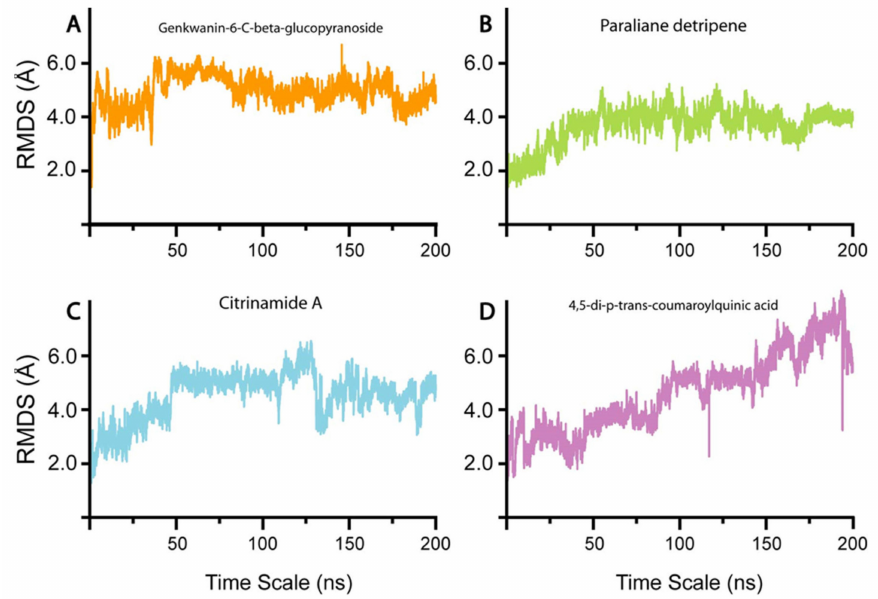
Figure 3. RMSD of all four system ( A ) Genkwanin-6-C-beta-glucopyranoside-nsp10 complex, ( B ) Par- aliane diterpene-nsp10 complex, ( C ) Citrinamide A, ( D ) 4,5-di-p-trans-coumaroylquinic acid. The x-axis shows the time scale in ns and the y-axis the RMSD in